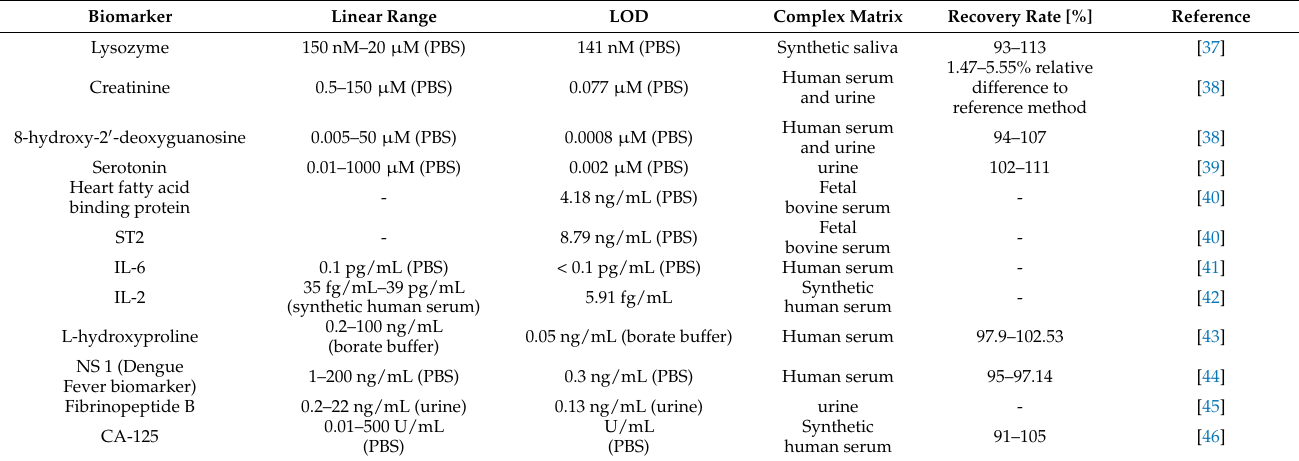
Table 1. A selection of target biomarkers for MIP-based sensors and their